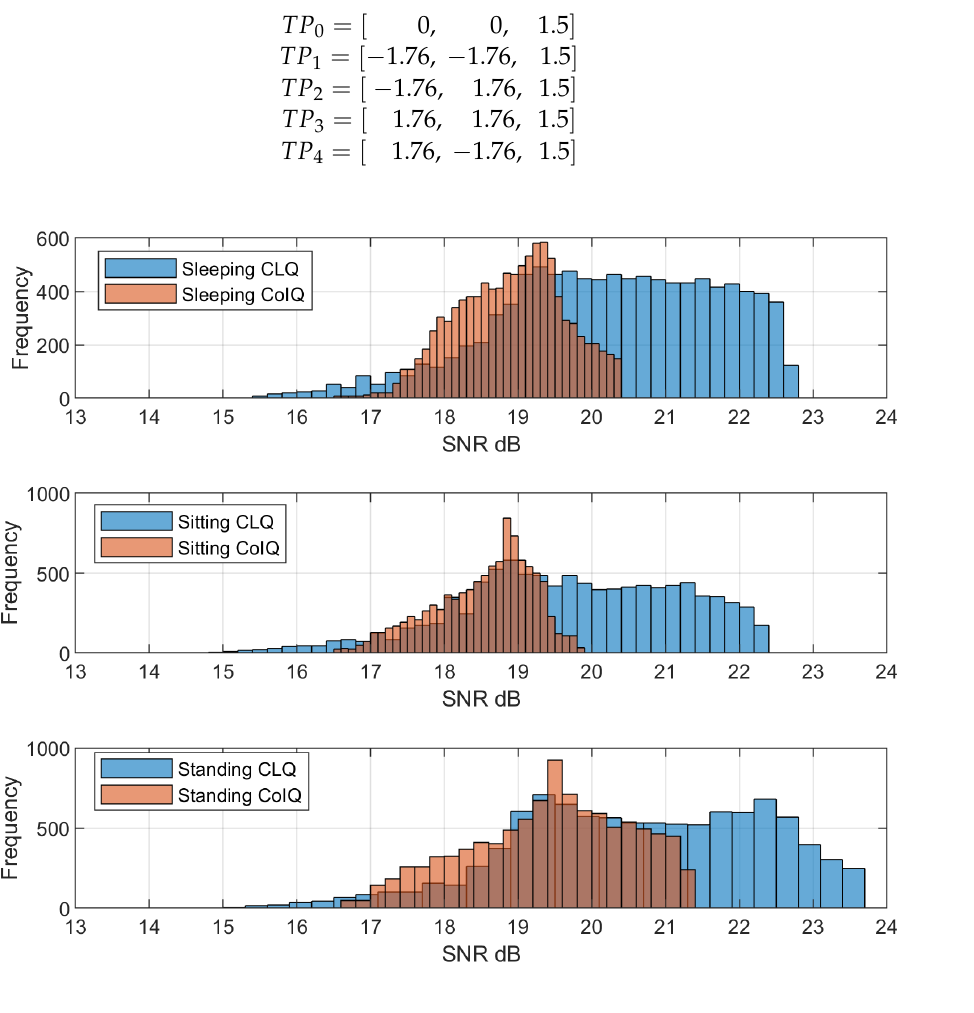
Figure 9. SNR histograms for sleeping, sitting and standing positions under low-intensity conditions in CLQ and CoIQ-9